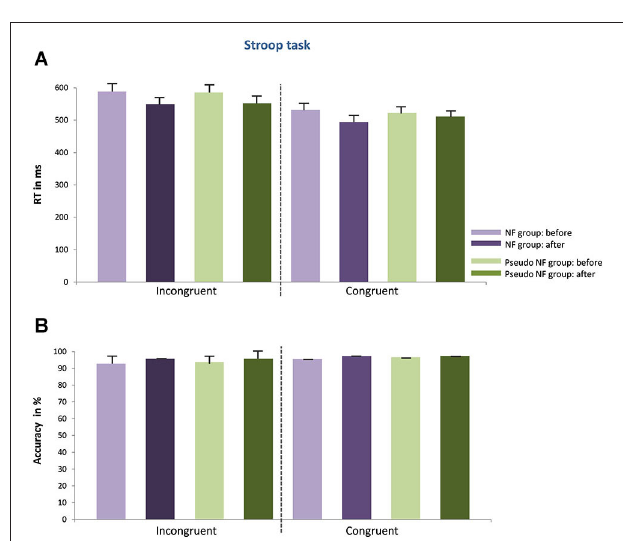
FIGURE 5 | Depicts the behavioral results of the Stroop task (mean RT in (A), accuracy scores in (B) including standard error of mean) for the